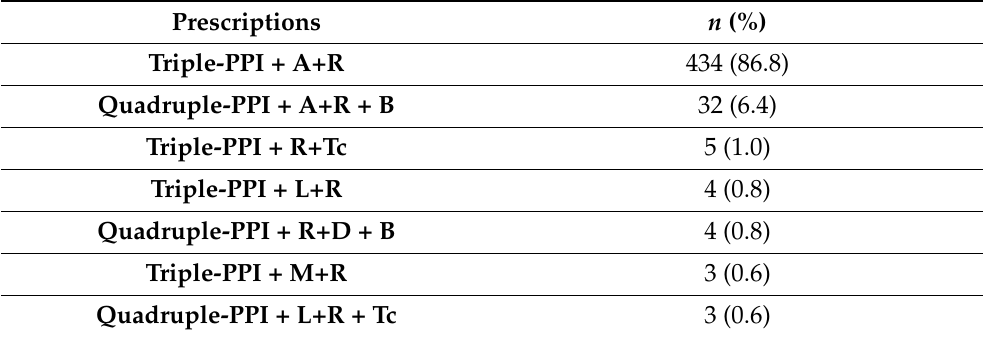
Table 1. Rifabutin-containing regimens registered in Hp-EuReg between 2013 and